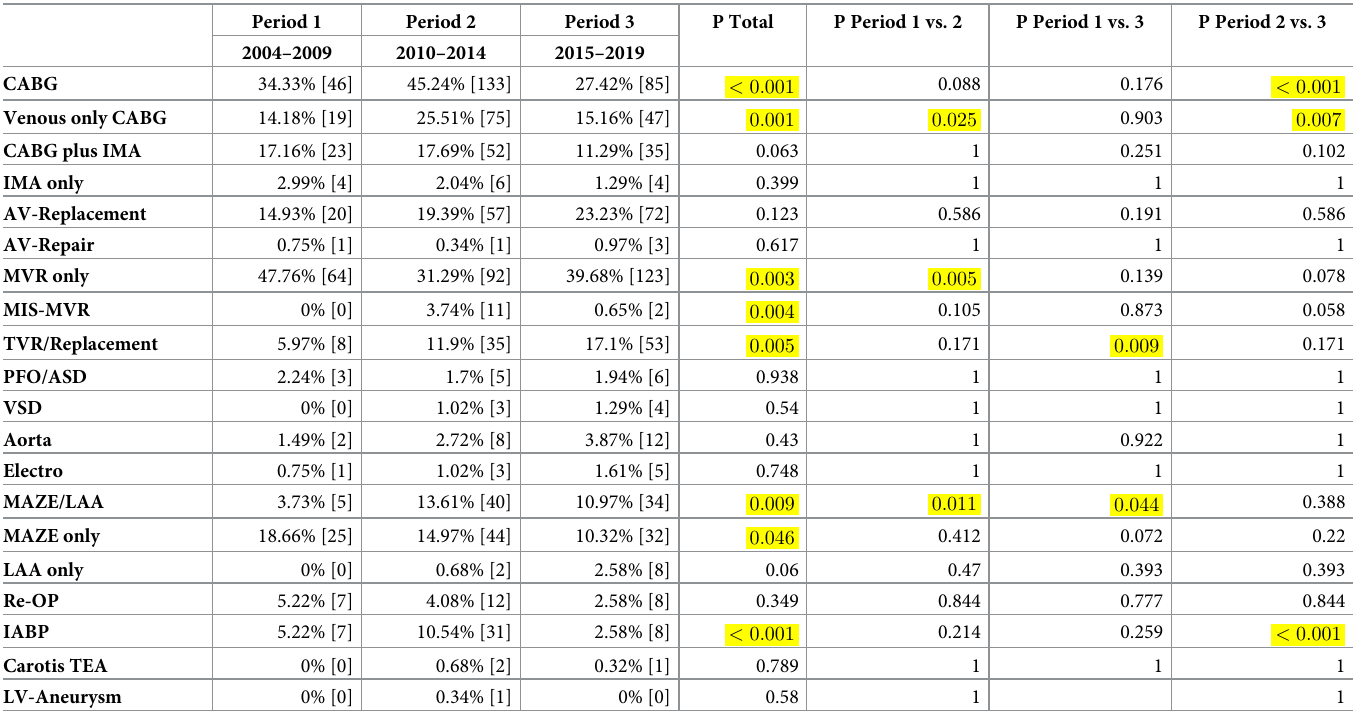
Table 2. Concomitant